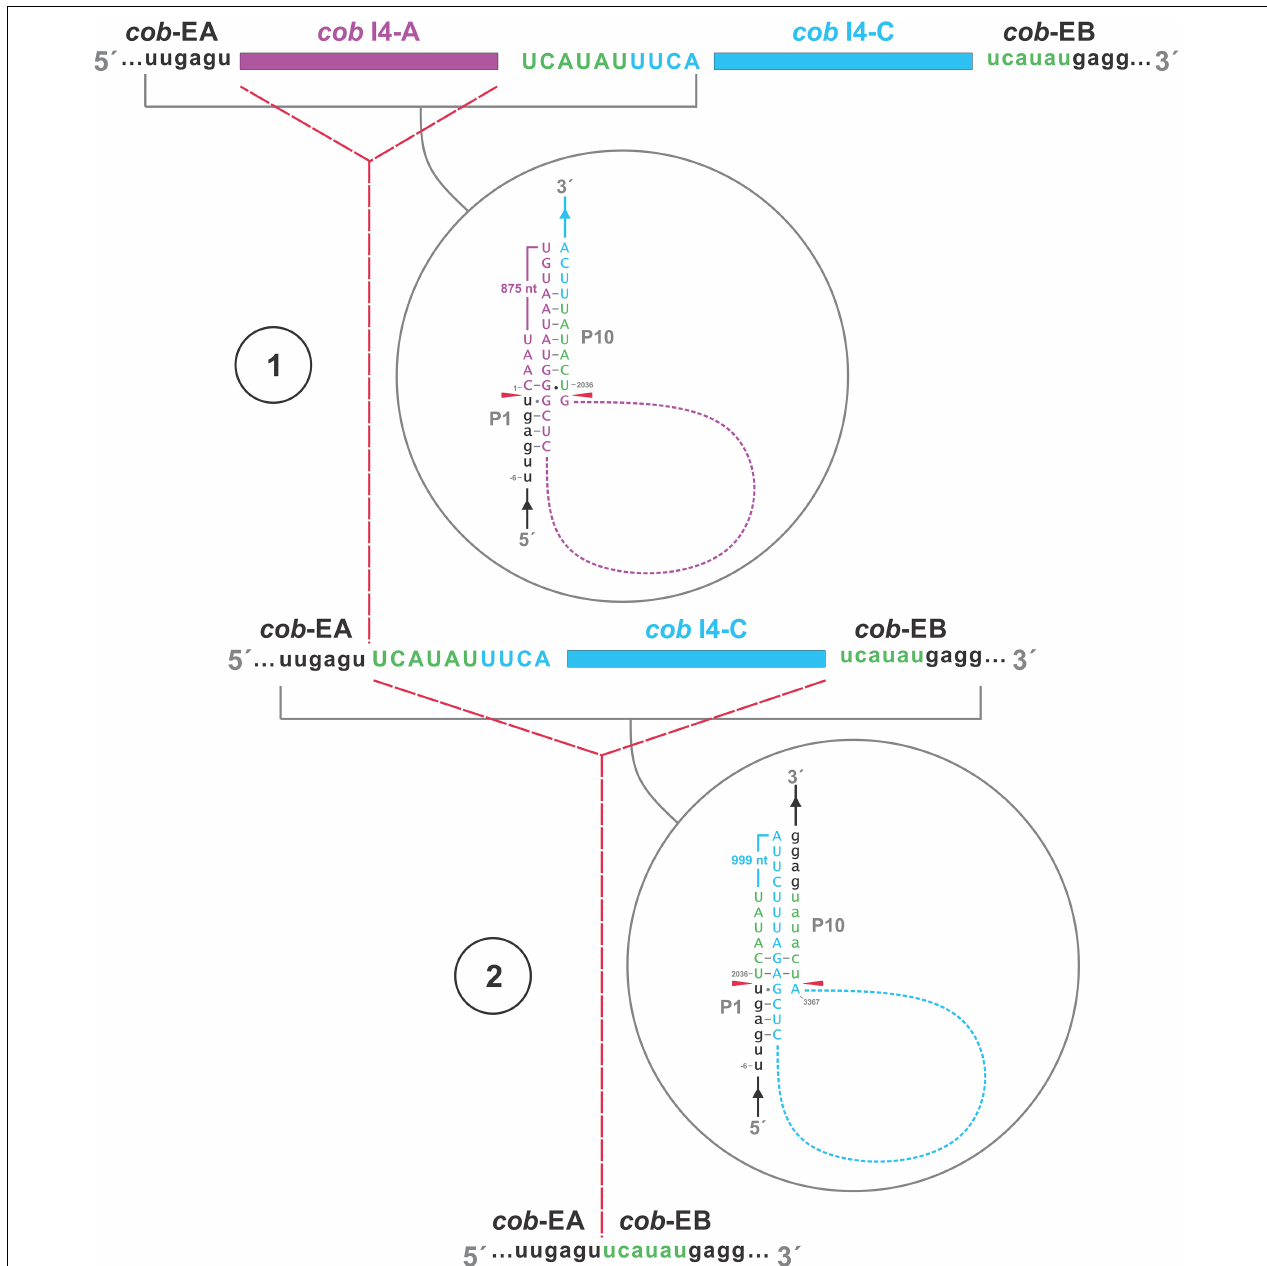
FIGURE 10 | Proposed RNA “ratchet-like” splicing model for cob I4 ( cob -490). As the group I intron modules are both 1A types they have similar sequence elements that allow for the formation of the helical regions between the two modules (P1–P9), thus functionally they can act like tandem introns, i.e., side-by-side introns. Splicing occurs via a two-step process: (1) The “upstream” intron initially splices out using a sequence, referred to as a potential pseudoexon, located between the “upstream” and “downstream” introns, and identical to the first six nucleotides of the downstream exon. (2) Subsequent splicing of “downstream” intron results in joining of the upstream and downstream exons. cob -EA and cob -EB refer to upstream and downstream exons, respectively. The pseudoexon and downstream exon are represented in green in uppercase and lowercase, respectively. cob I4-A (purple) and cob I4-C (blue) refer to the “upstream” and “downstream” introns, respectively. Proposed P1 and P10 interactions are shown in gray